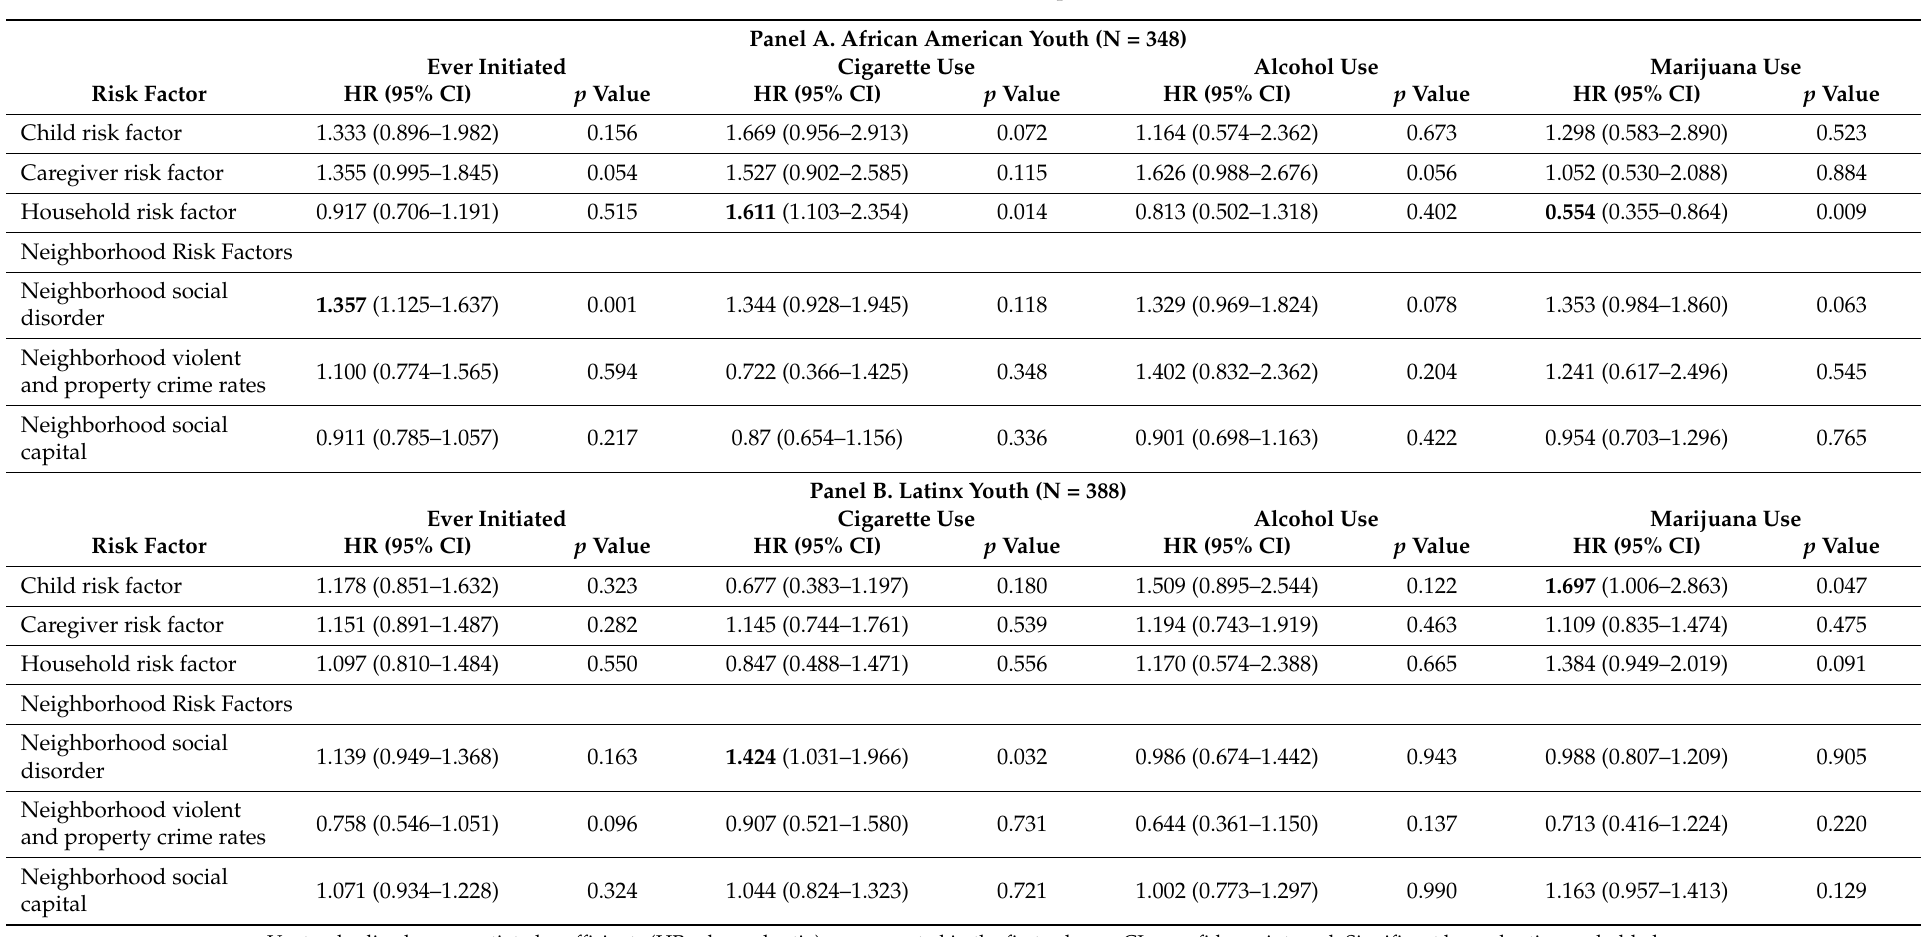
Table 4. Results of stratified Cox cause-specific hazards